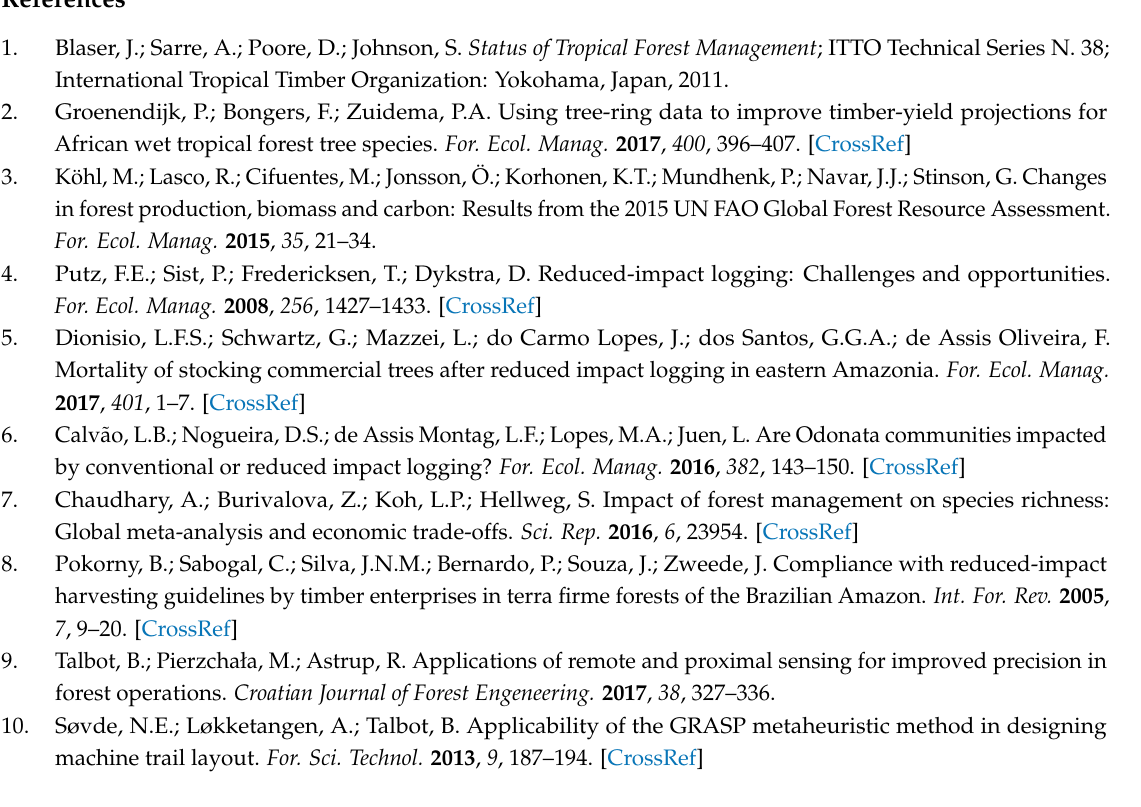
Figure S1: Skid trails with the shortest distances defined by the algorithm and following the network configuration with common tracks for more than one